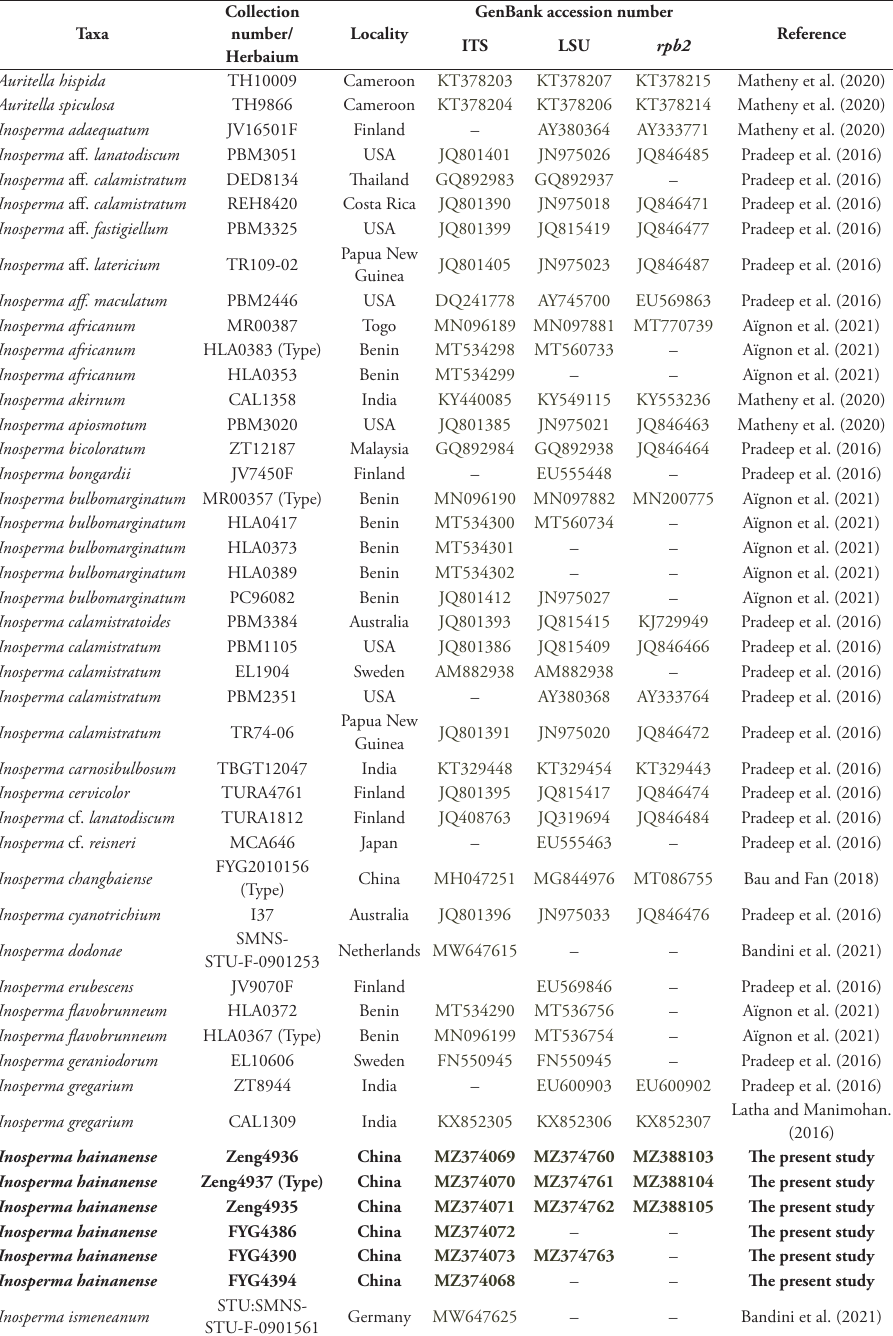
Table 1. Taxon sampling information and DNA sequences used for phylogenetic